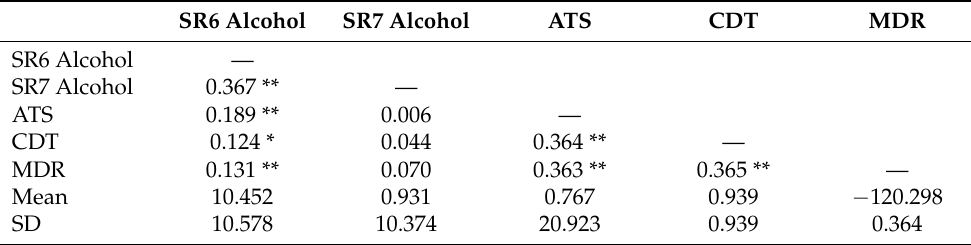
Table 4. Partial correlation coefficients of each of the metrics for alcohol consumption risk to them- selves after controlling sex and nicotine.